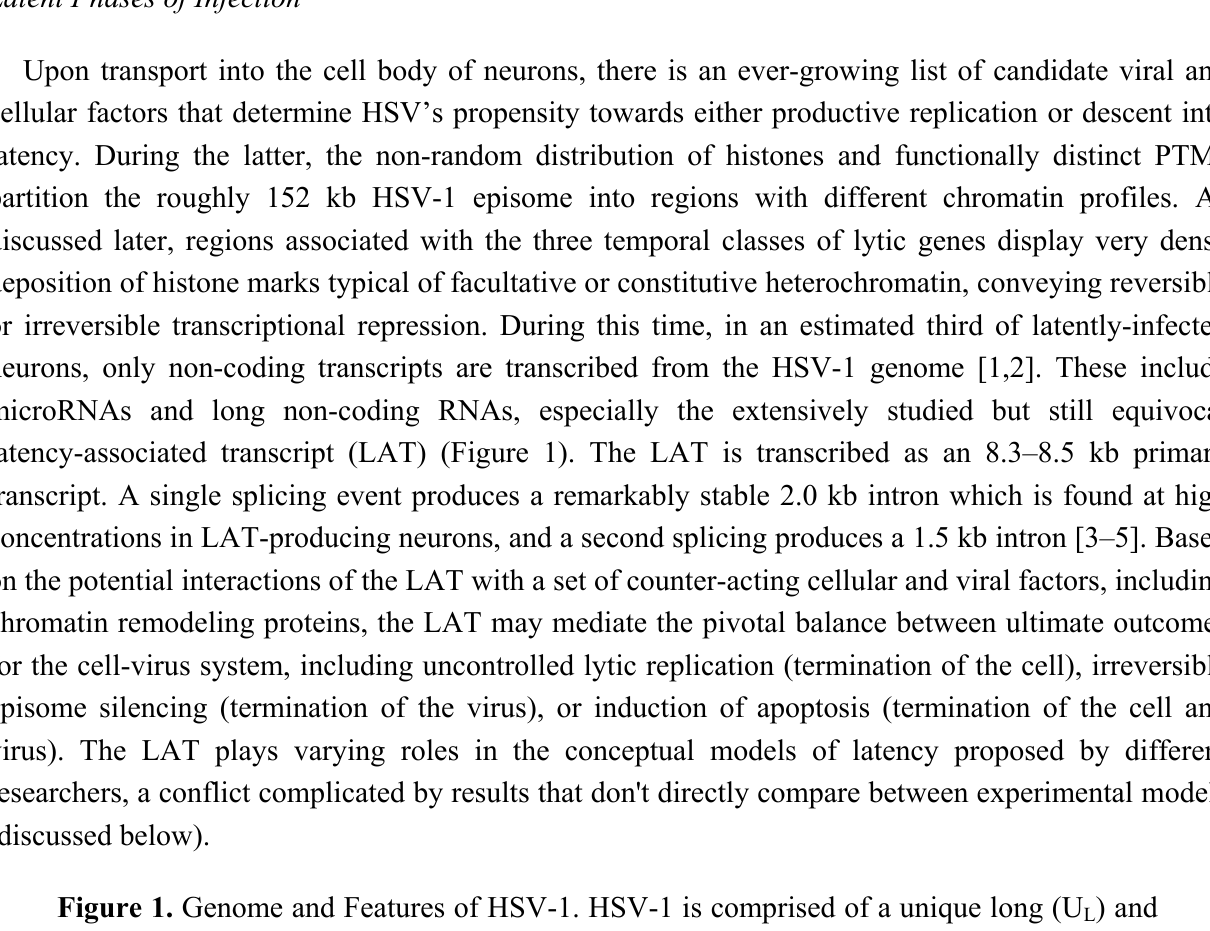
unique short (U ) region flanked by long and short repeat regions. The S